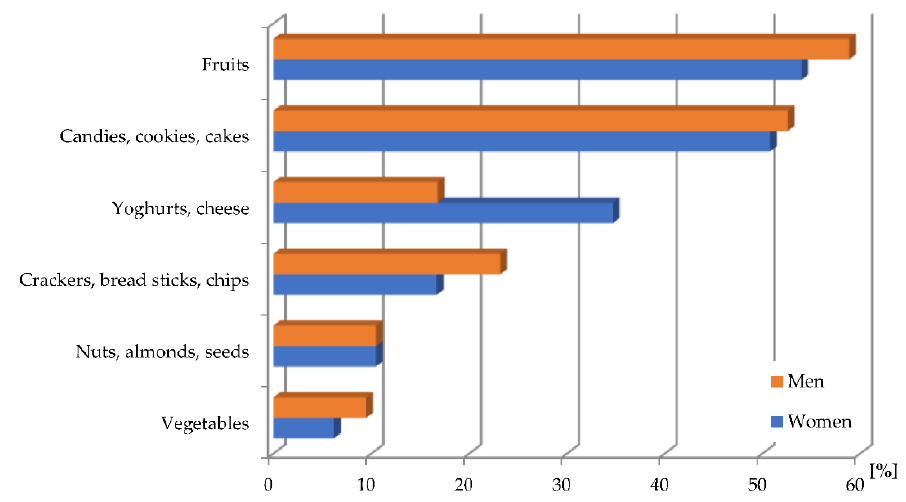
Figure 1. Most frequently chosen snacks by male and female [%]. Table 4. Frequency of consumption of selected groups of food